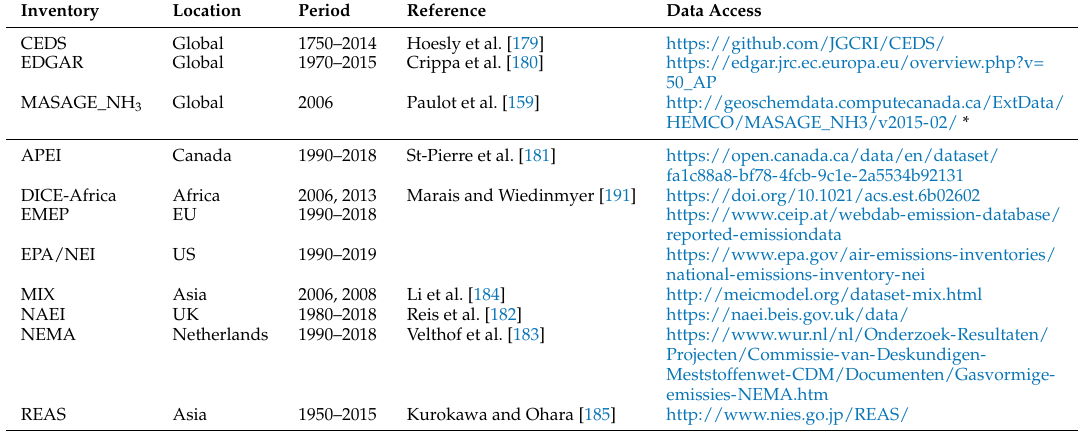
Table 5. Global and regional ammonia emission